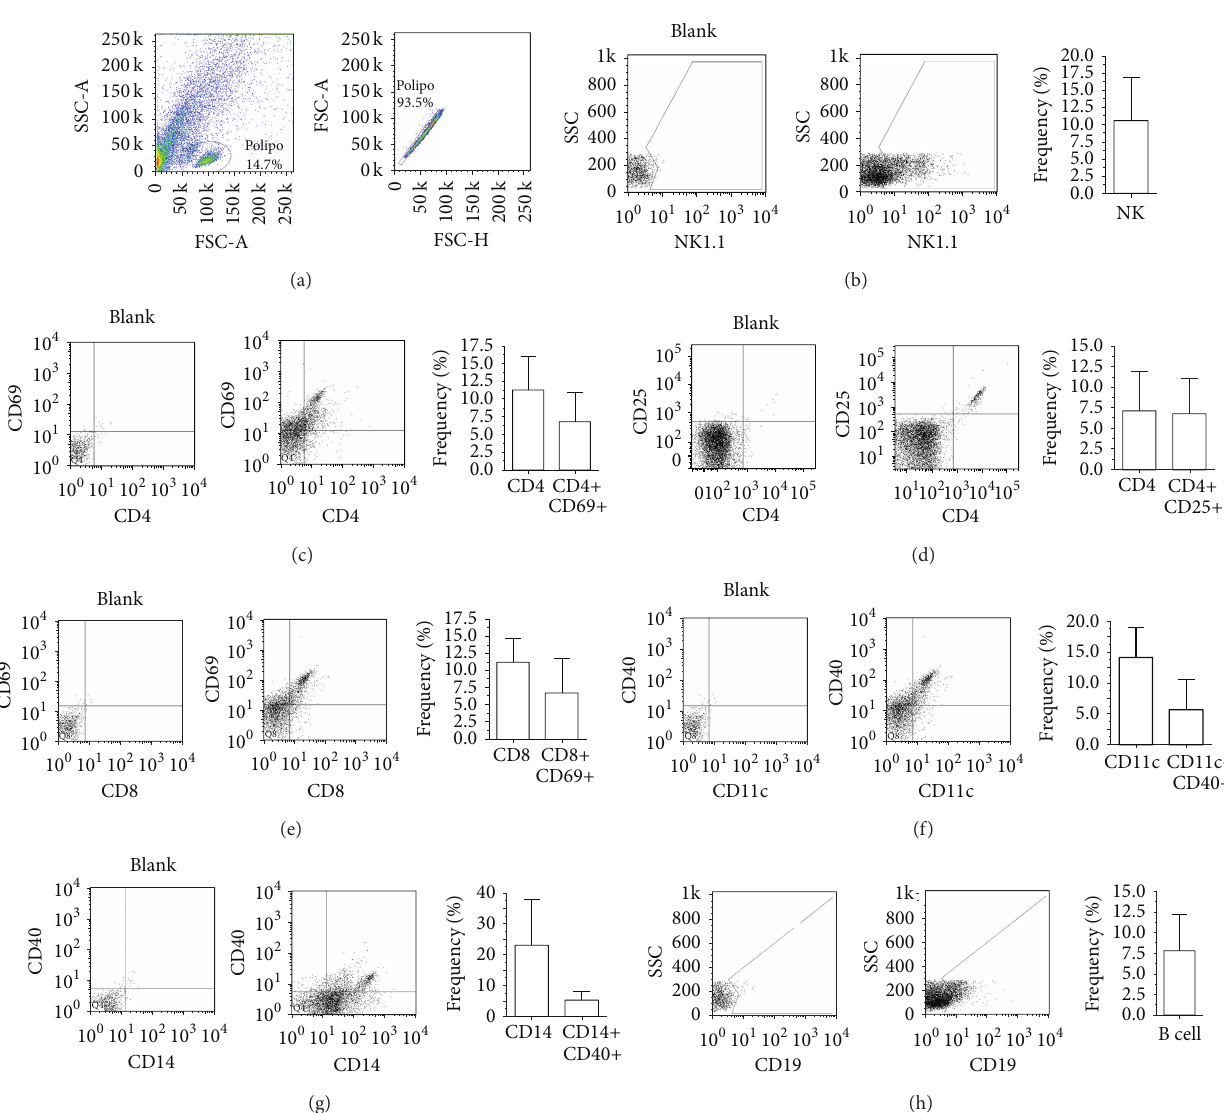
Figure2:Phenotypicaspectsofpolyp-derivedcells.(a)Gatestrategiesforselectionofthemononuclearfractionofpolyp-derivedcells;(b)NK cells (NK1.1+); (c) CD4 and CD4+CD69+ T cells; (d) CD4+CD25+ T cells; (e) CD8 and CD8+CD69+ T cells; (f) CD11c+ and CD11c+CD40+ dendritic cells; (g) CD14+ and CD14+CD40+ monocytes and (h) B cells (CD19+). Several types of activated and nonactivated immune